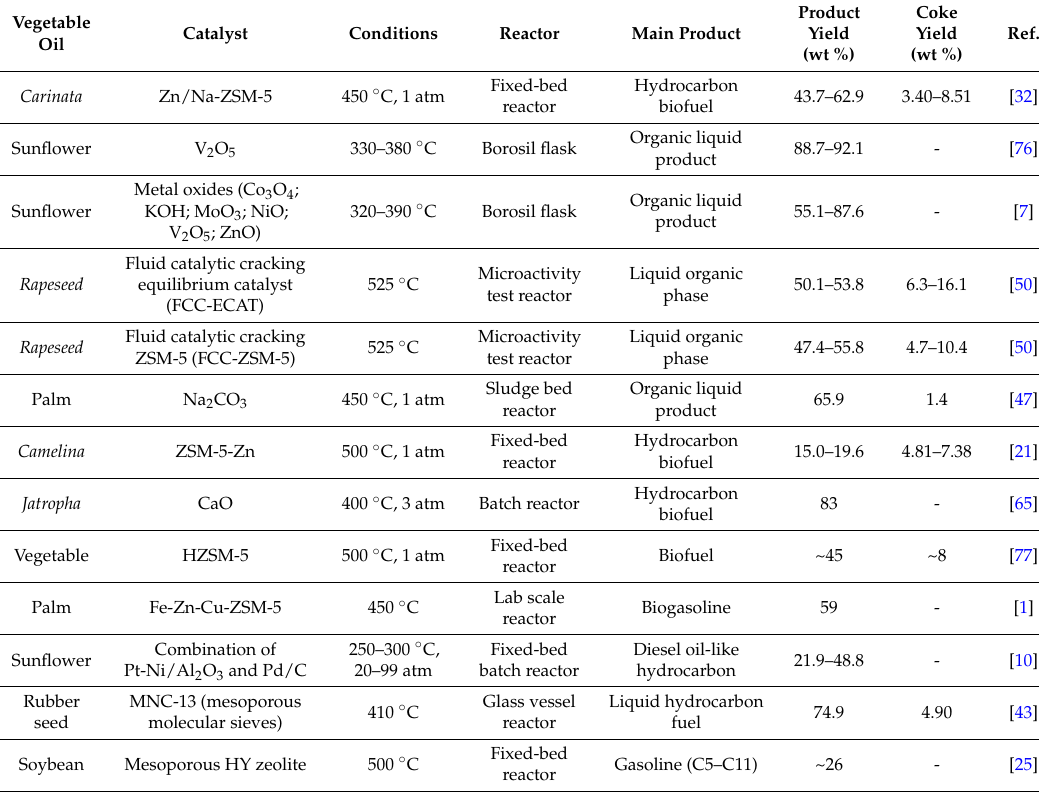
Table 4. Recent progresses in catalytic cracking of vegetable oil to hydrocarbon